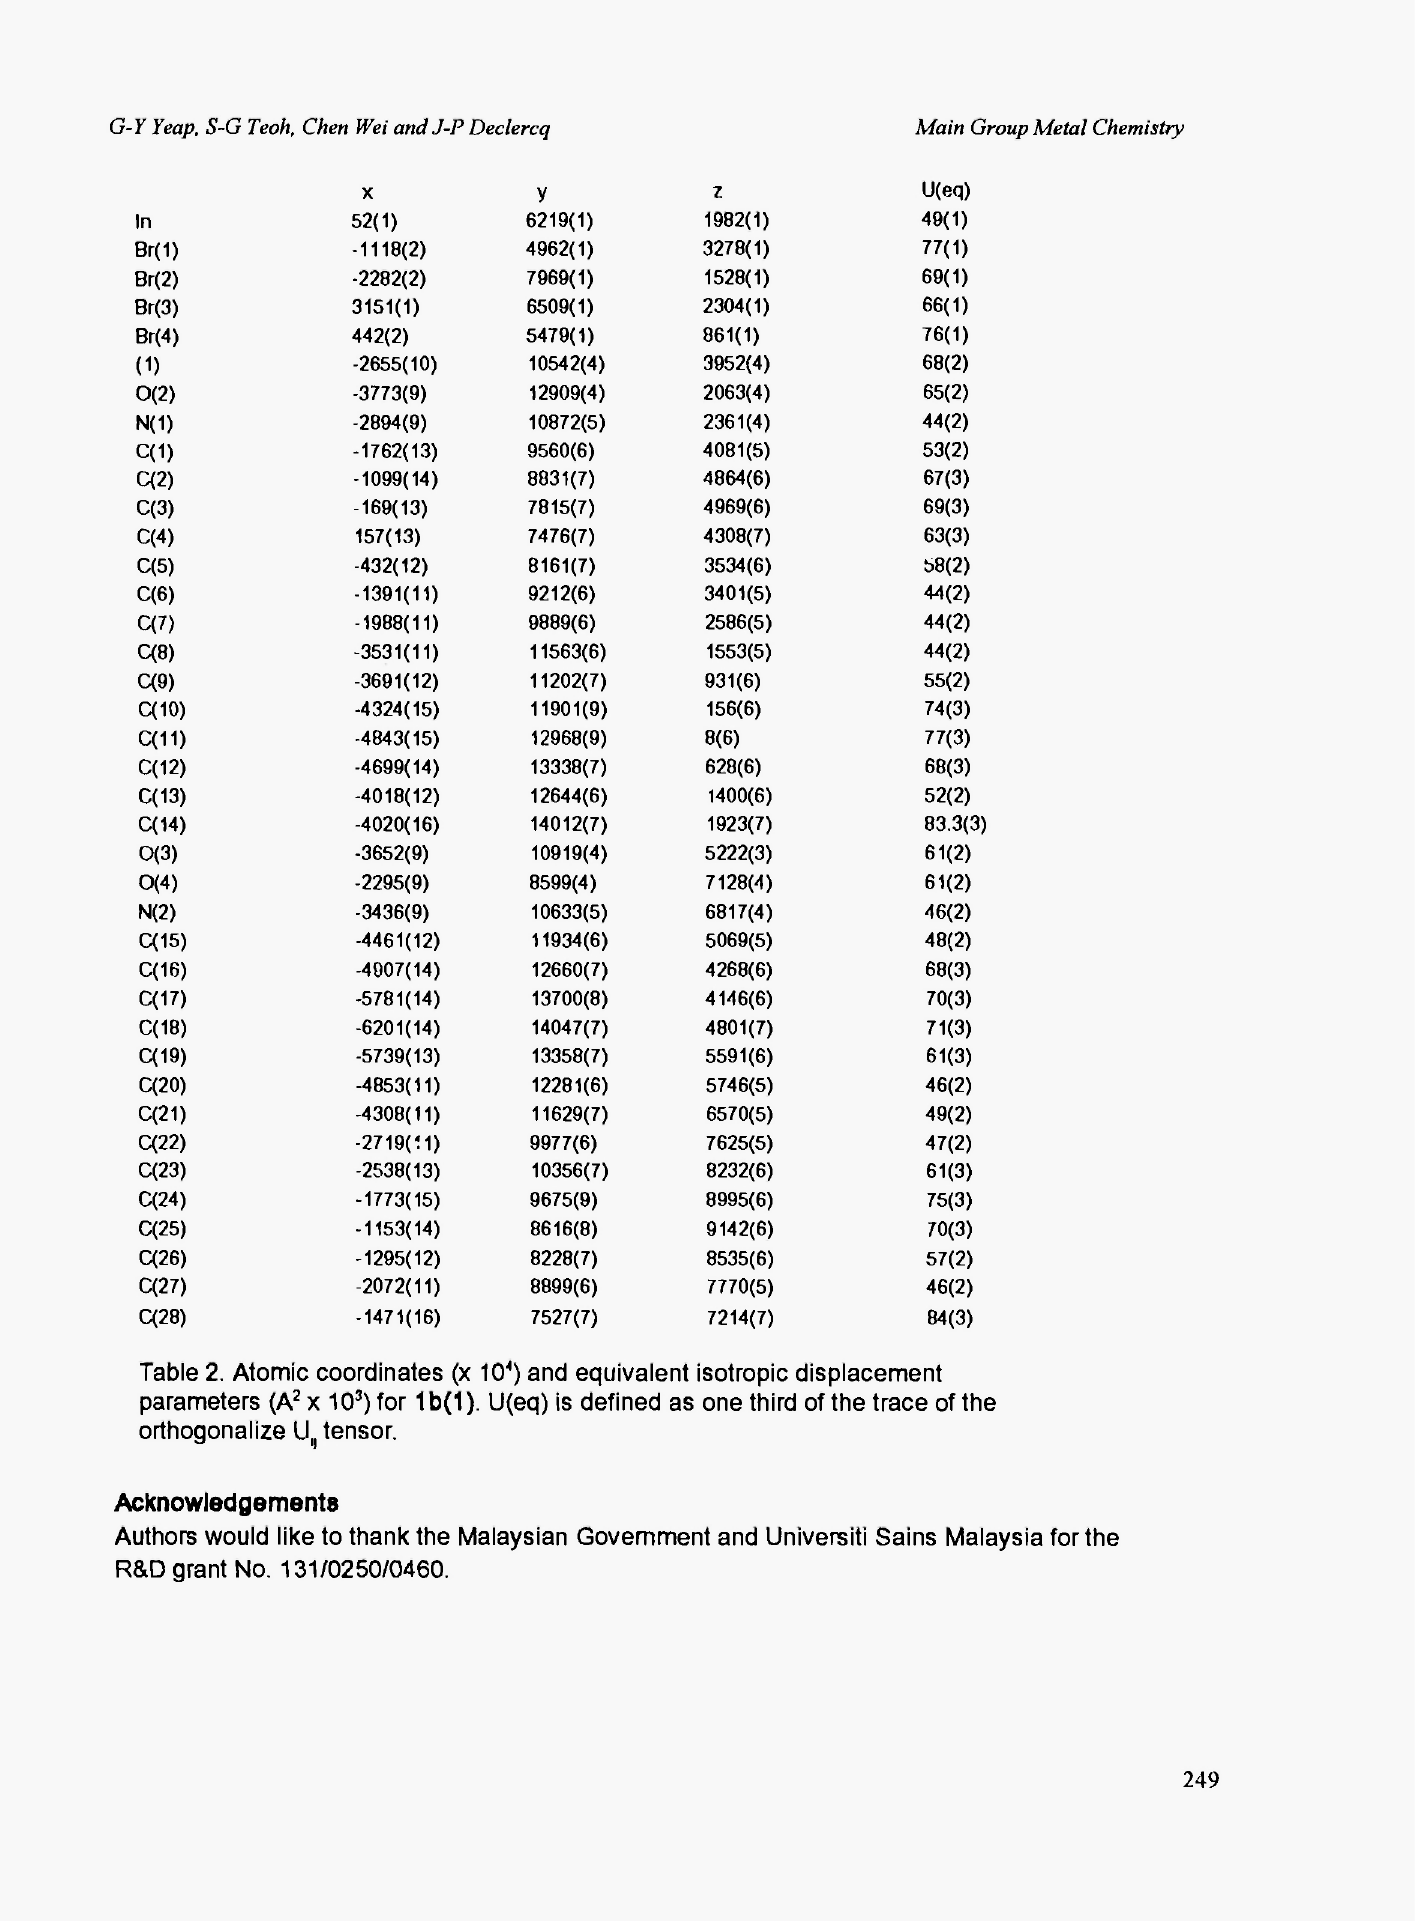
Table 2. Atomic coordinates (x 10*) and equivalent isotropic displacement parameters (Α 2 χ 10 3 ) for 1b(1). U(eq) is defined as one third of the trace of the orthogonalize ll,,